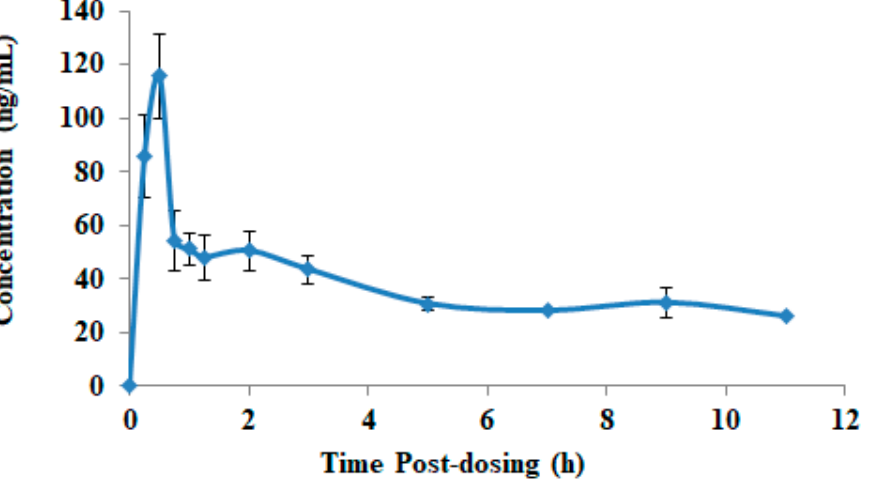
Figure 5. Mean plasma concentration-time profiles of baeacitinib.